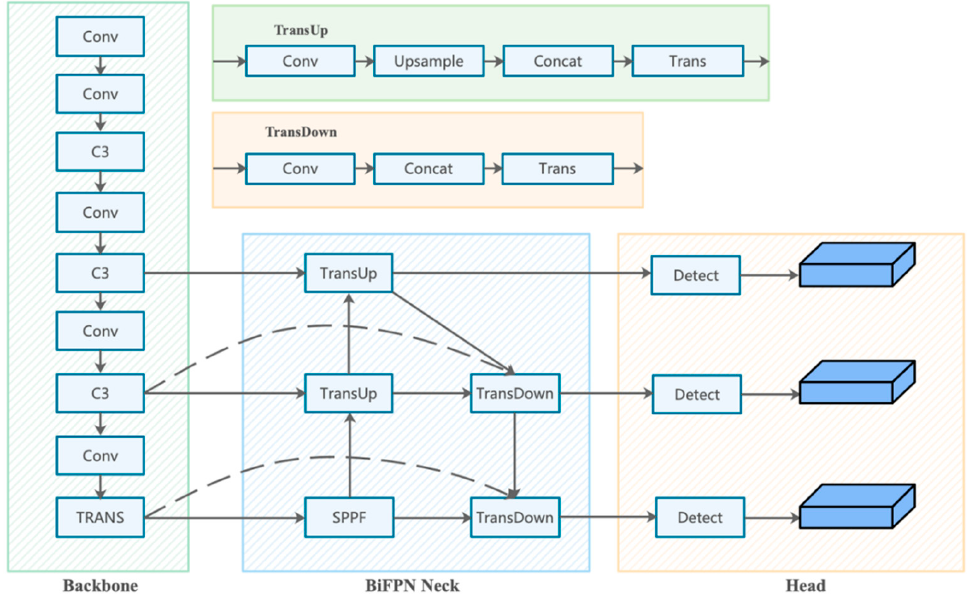
Figure 2. The whole network structure. (1) CSPDarknet53 backbone with a TRANS module at the end. (2) Neck using the structure of the BiFPN. (3) Feature map of three detection heads using the TRANS module in neck.